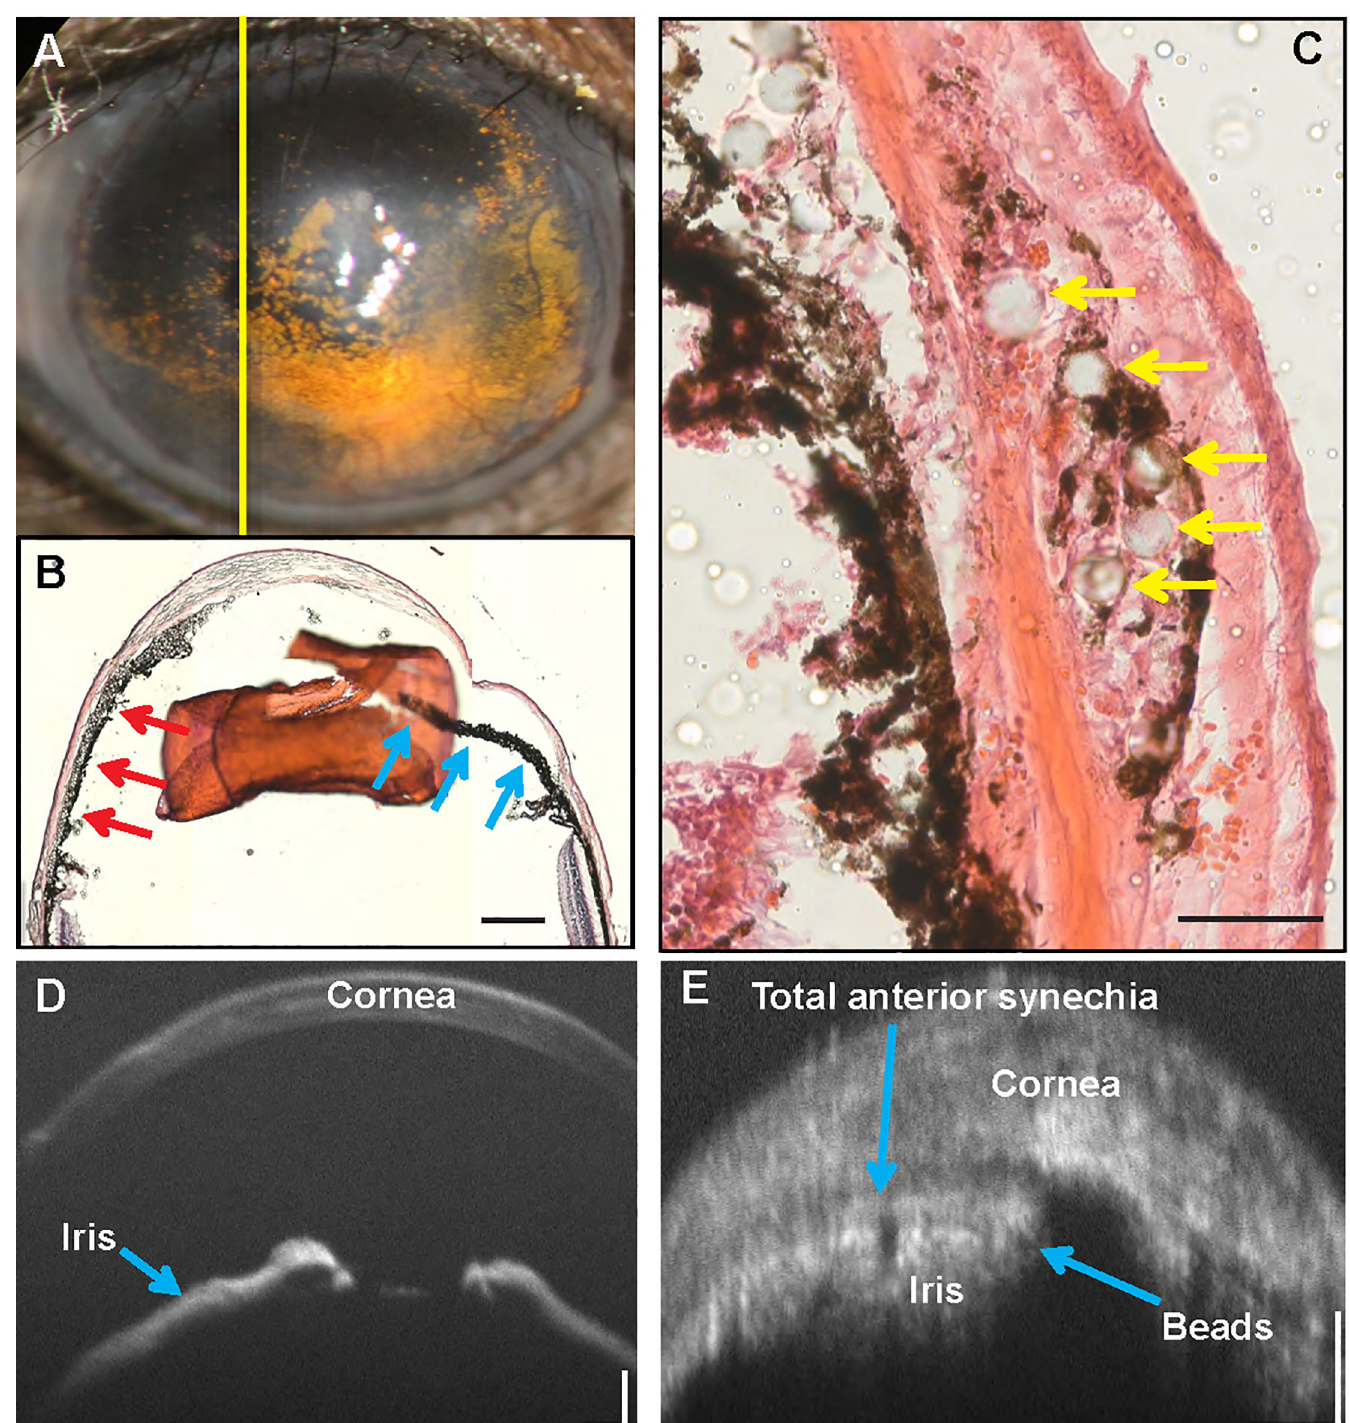
Fig 2. Peripheral synechiae and direct occlusion of Schlemm’s canal by microbeads. Hematoxylin and Eosin staining of the anterior segment was performed at 30 days post-injection. (A) Image showed the sliced site of (B), (B) Peripheral synechiae formation with attachment of the corneal endothelium to the inferior iris (red arrows). The superior angle was open (blue arrows). Bar = 500 μ m. (C) Microbeads (yellow arrows) occluding Schlemm’s canal. Bar = 50 μ m. (D) Optical coherence tomography (OCT) image of the anterior segment in a normal eye. Bar = 100 μ m (E) OCT image of the anterior chamber at 30 days post-injection with development of peripheral anterior synechiae. Bar = 100 μ